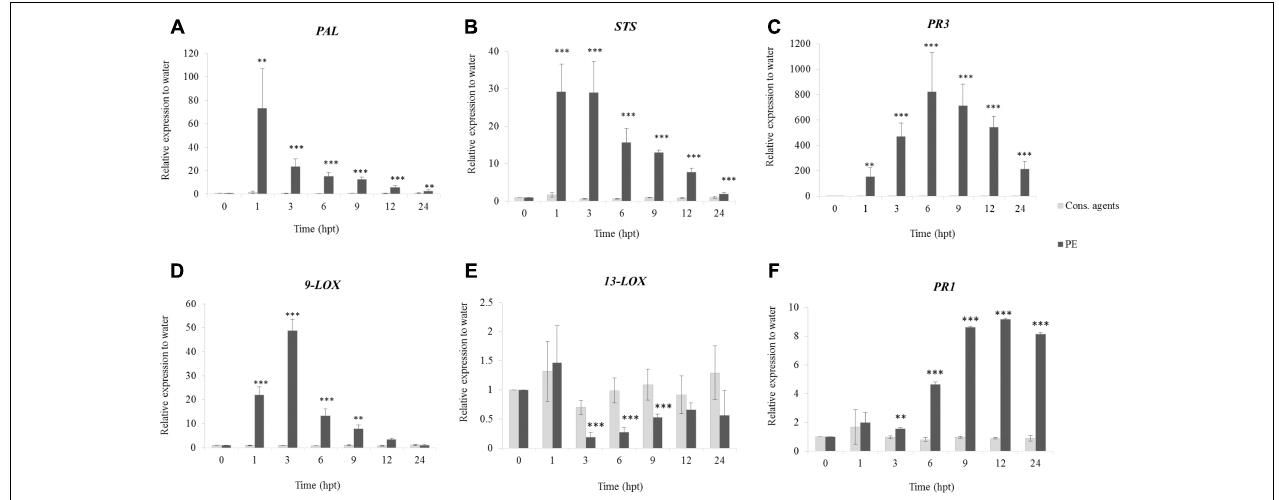
FIGURE 3 | Relative expression of defense-related genes in grapevine cells in response to PE treatment. Cell suspensions, adjusted to 0.1 g FWC mL − 1 , were treated with PE (0.5 g L − 1 ), or equal volumes of cons. agents or water. Six genes encoding a (A) phenylalanine ammonia-lyase (PAL); (B) stilbene synthase (STS); (C) chitinase 4c (PR3); (D) lipoxygenase 9 (9-LOX); (E) lipoxygenase 13 (13-LOX); and (F) pathogenesis-related protein 1 (PR1) were investigated by qRT-PCR. Results represent relative fold expression calculated with the 2 − (cid:49)(cid:49) Ct method, compared to the housekeeping gene EF1 α and to water control for each respective time point. Data correspond to the mean ± confidence interval of three independent biological repetitions with three technical replicates each. Significant differences were identified with Student t -test compared to cons. agents condition ( ∗ p < 0.05; ∗∗ p < 0.01; ∗∗∗ p < 0.001).